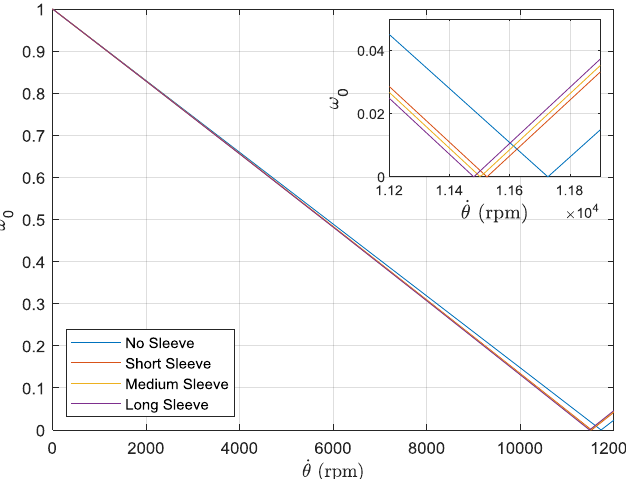
Figure 6. Campbell diagram for finite element model with point masses. Inset shows natural frequencies and rotational velocity close to critical speeds.